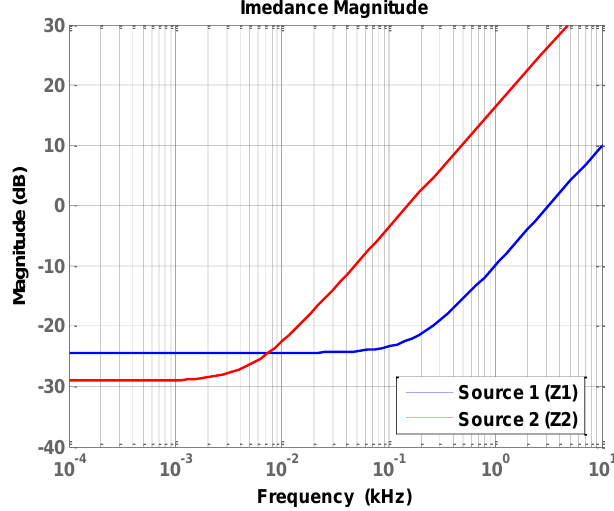
Figure 9. Frequency characteristics of impedances for source 1 and source 2.